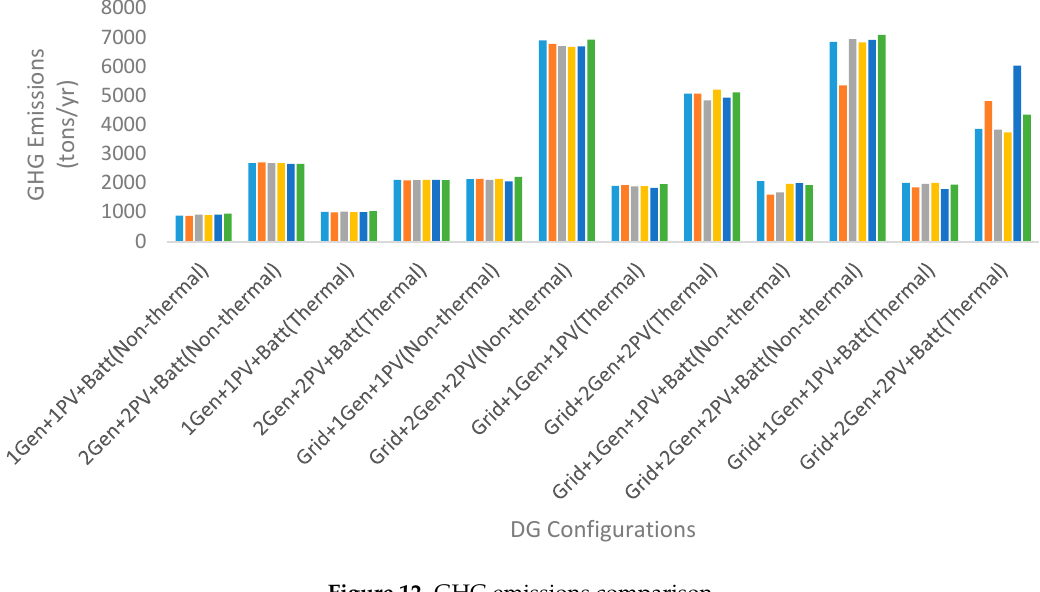
Figure 12. GHG emissions comparison.